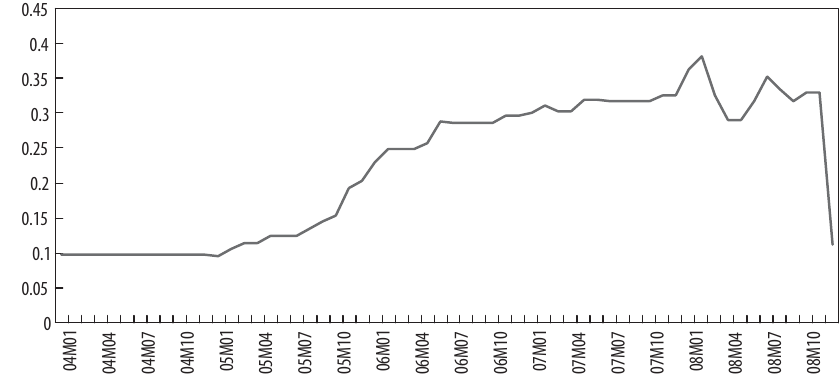
Figure 4. Proportion of bubble price accounting for the housing price